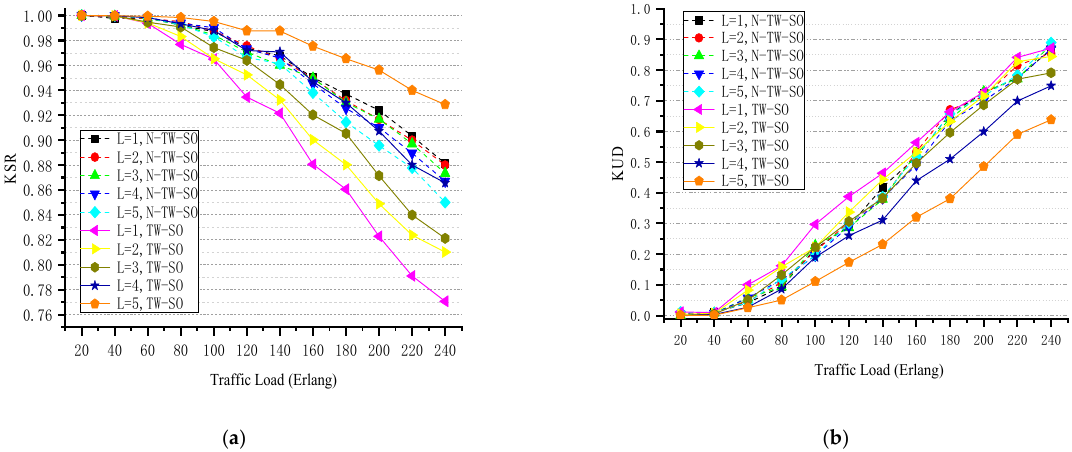
Figure 5. ( a ) Key success rate (KSR) vs. traffic load; ( b ) Key-updating delay (KUD) vs. traffic load.